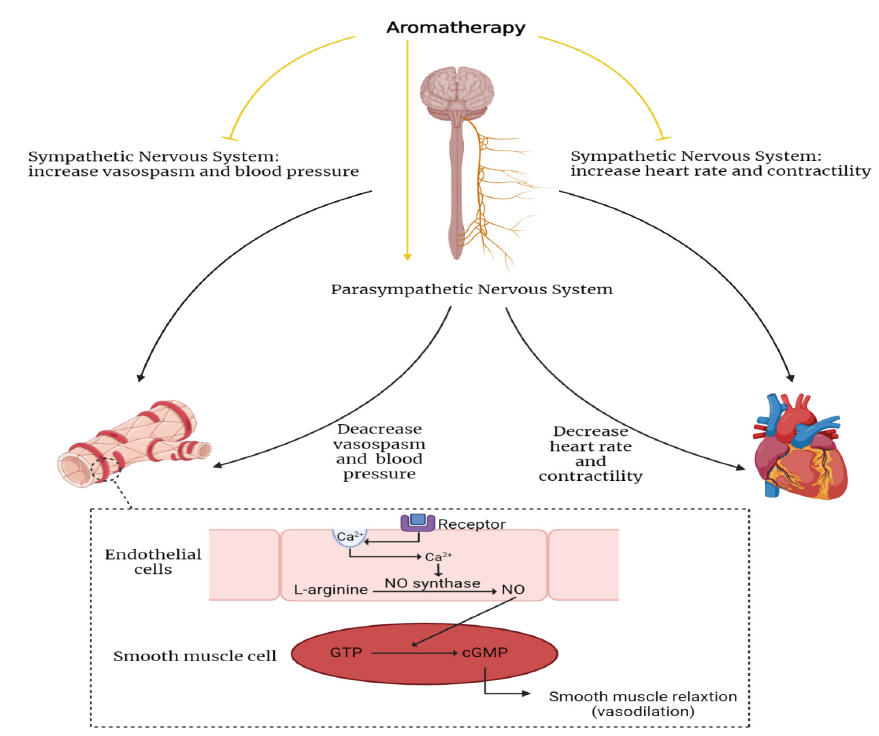
Figure 2. The most important known mechanisms of aromatherapy on hemodynamic